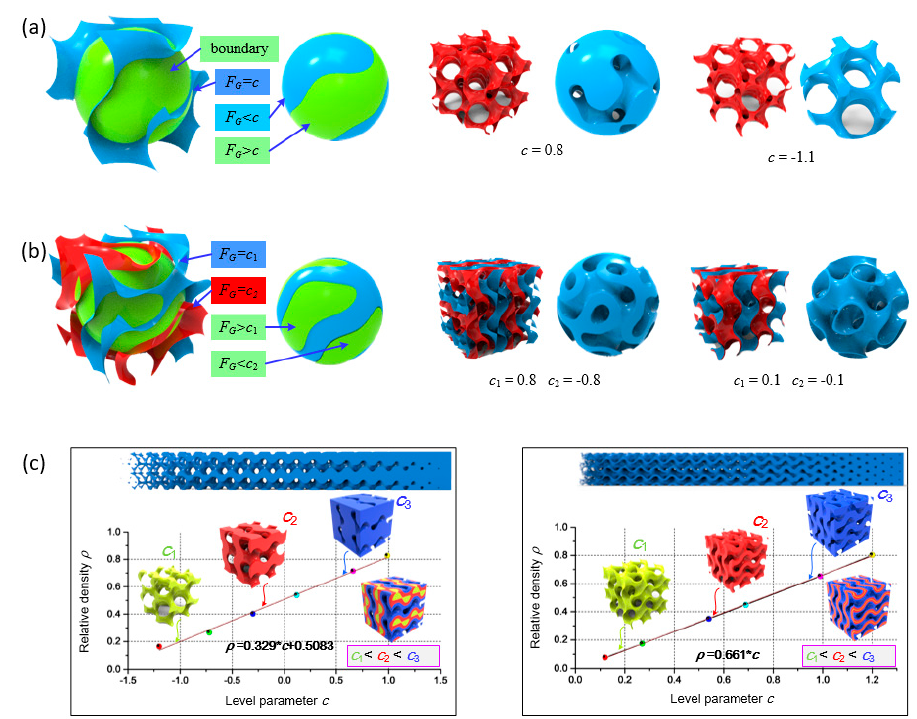
Figure 1. Illustration of Triply periodic minimal surface (TPMS) scaffolds: ( a ) a network-based scaffold, ( b ) a sheet-based scaffold, and ( c ) the relationship between relative density and the level parameter for two types of scaffolds.